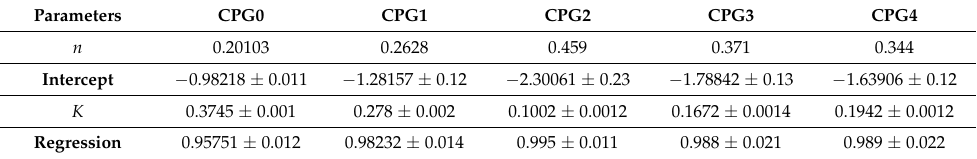
Table 2. Swelling kinetics parameters of CPG